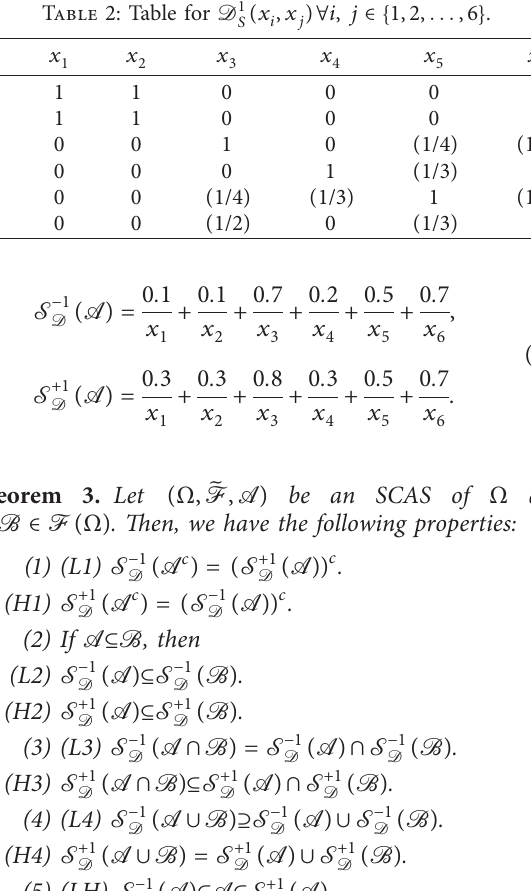
Table 2: Table for D 1